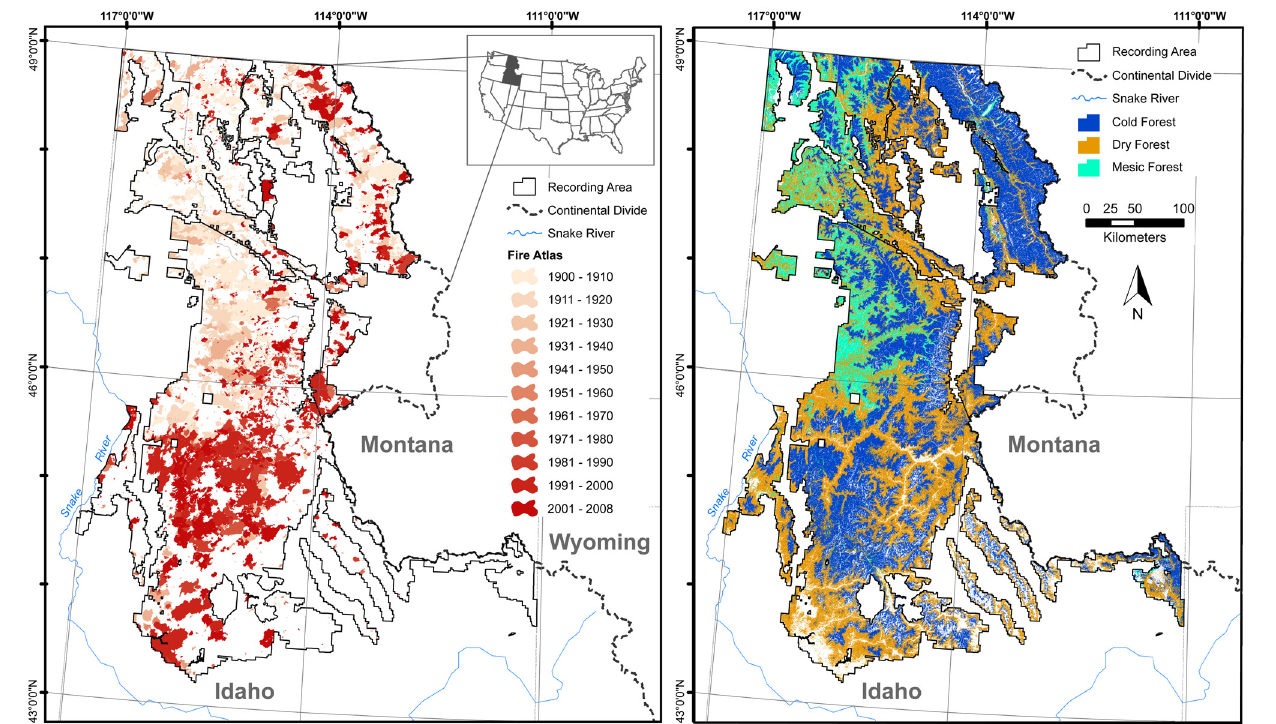
Fig 2. The U.S. Northern Rockies study area in Idaho and portions of Montana, west of the Continental Divide. Area burned, stratified by decade (left), and the three dominant forest types across the study area (right).